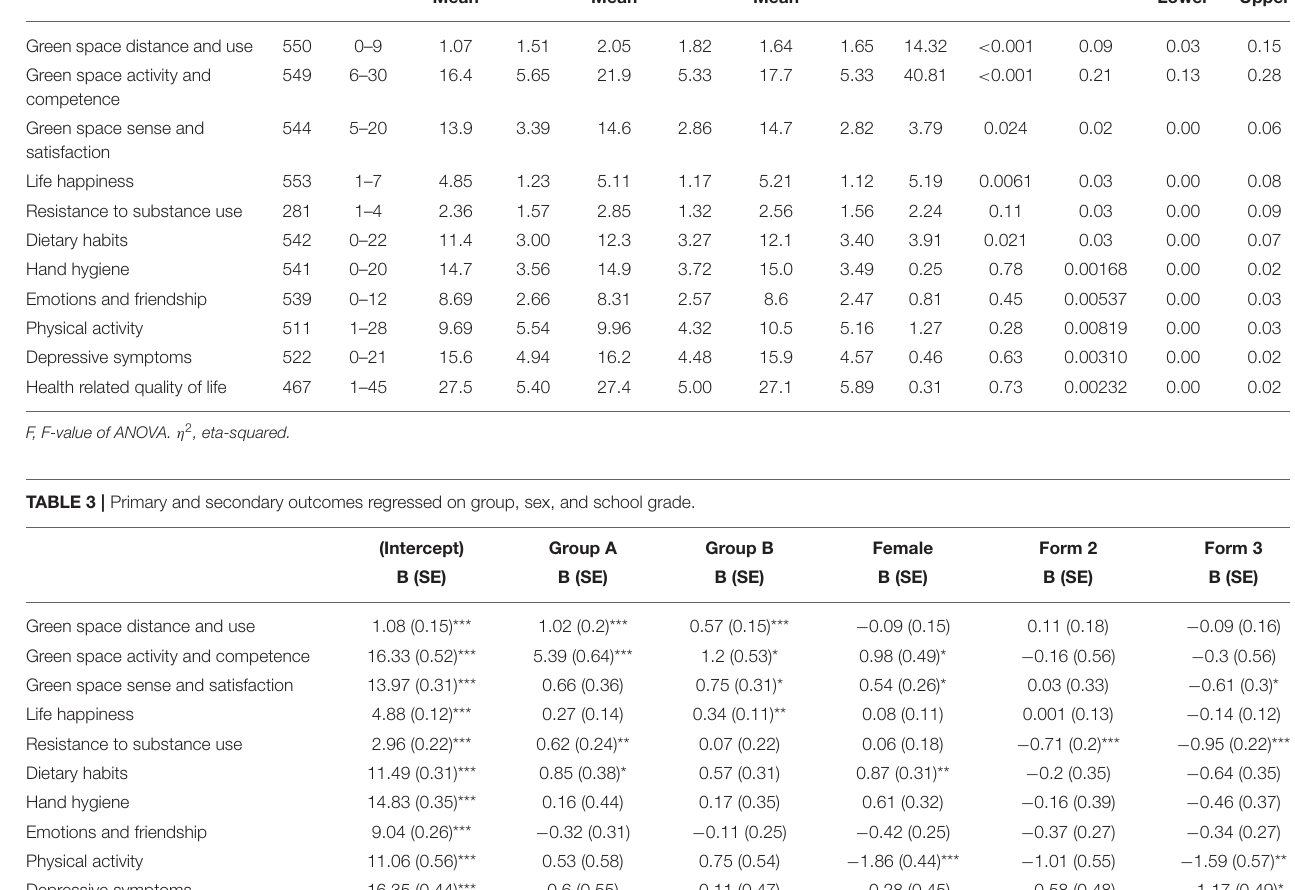
TABLE 2 | Between group comparisons for primary and secondary outcomes. N Range Control SD Group A SD Group B SD F p η 2 95% CI Mean Mean Mean Lower Upper